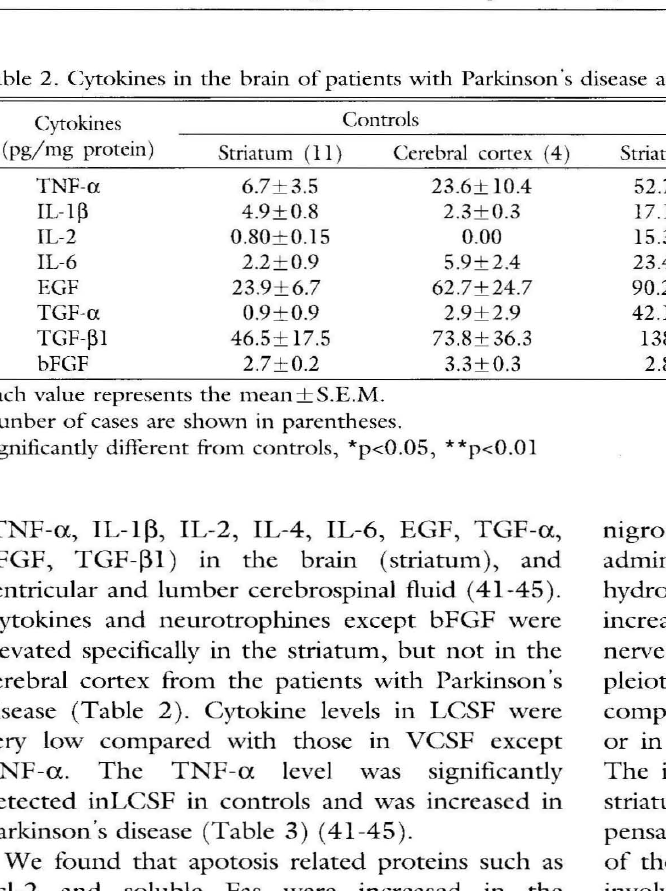
Table 2. Cytokines in the brain of patients with Parkinson's disease and controls Cytokines Controls